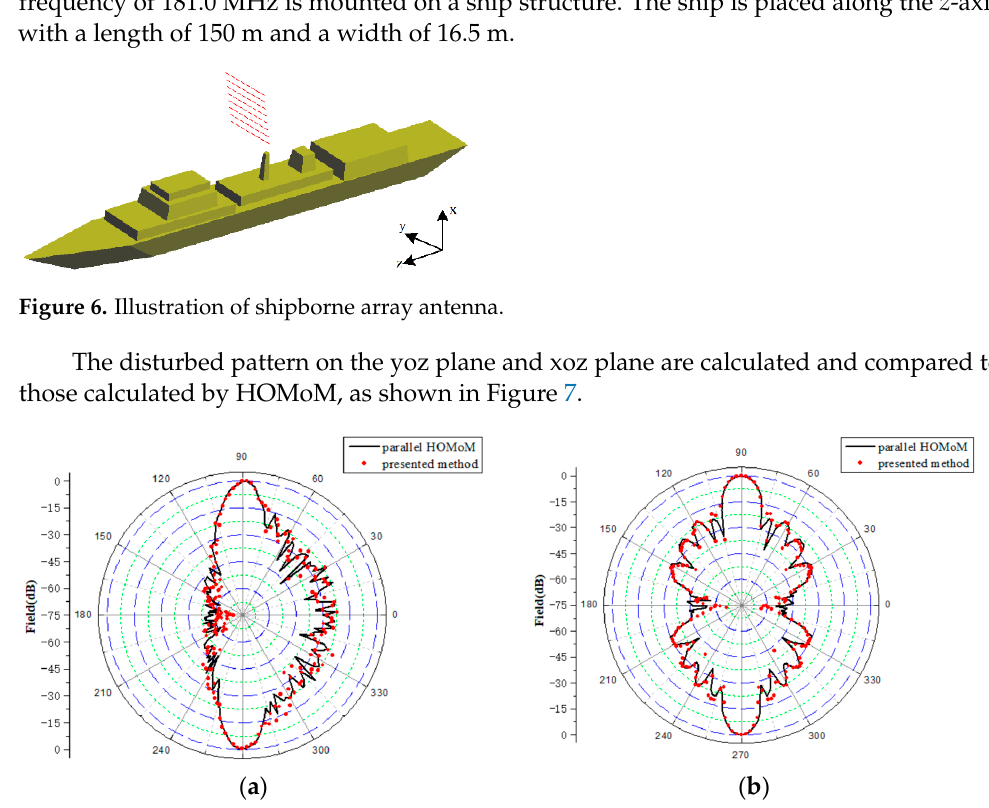
Figure 7. ( a ) Disturbed pattern on xoz plane; ( b ) disturbed pattern on yoz plane.